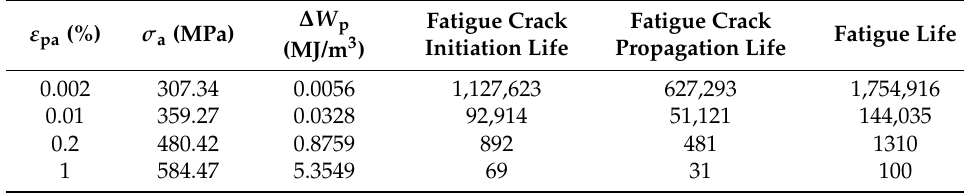
Table 6. Life estimation of LY12.